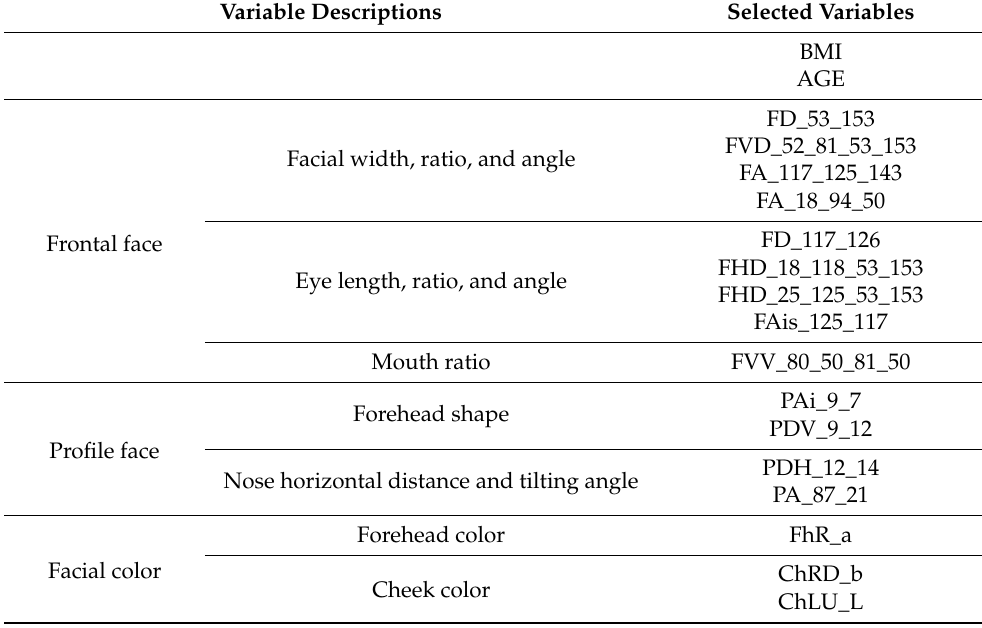
Table 6. Variables selected using a model based on LASSO in men.